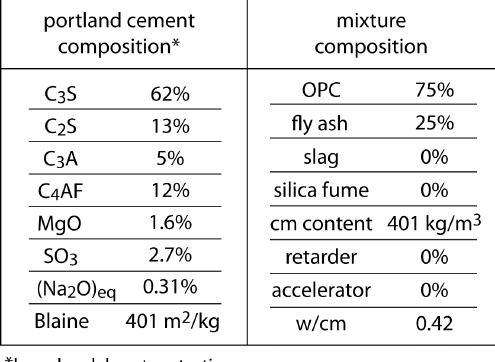
Figure 13. Input parameters for hydration